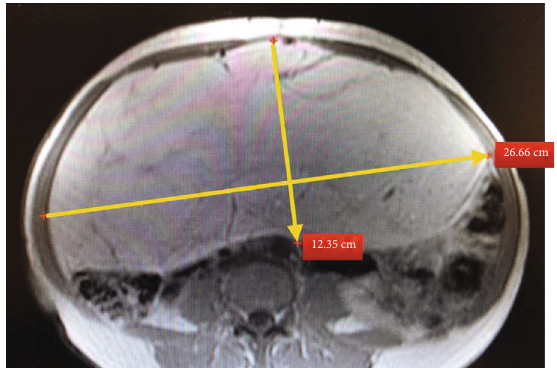
Figure 1: Axial view of magnetic resonance imaging shows that the lesion is encapsulated and